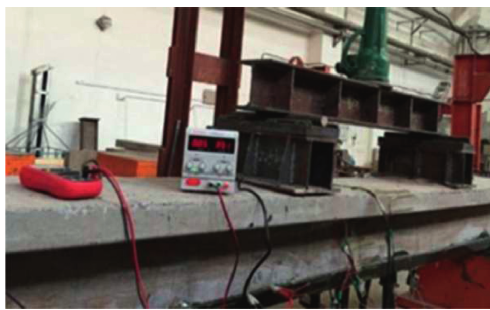
Figure 8: Resistance test